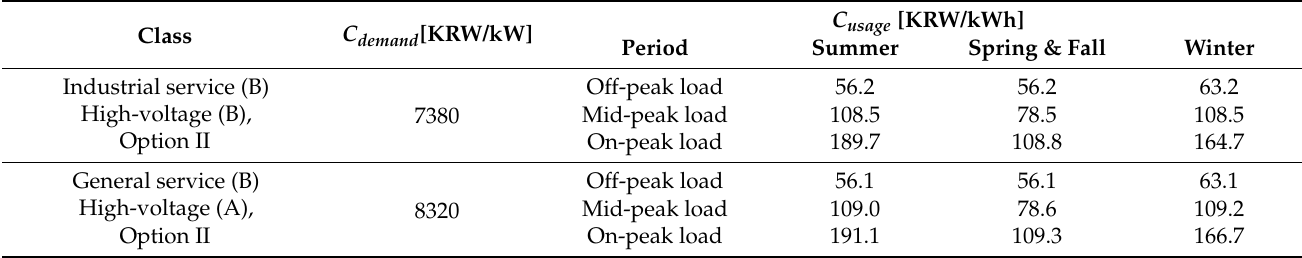
Table 2. Examples of electricity rate tables for industrial and general customers [5].